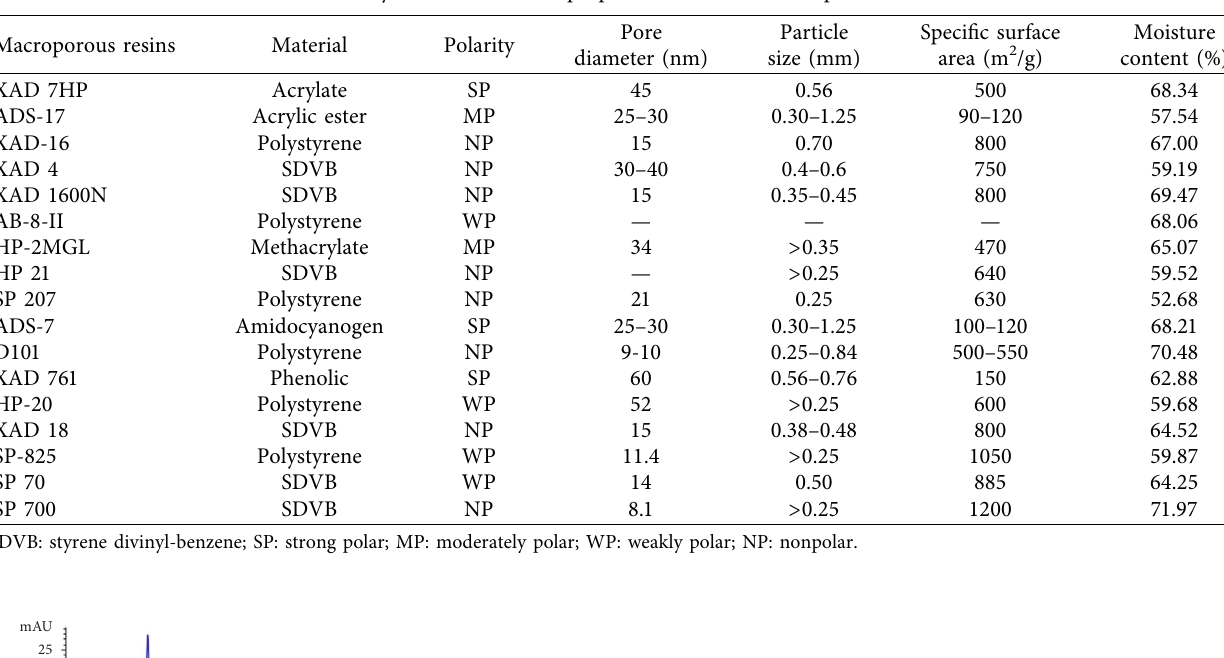
Table 1: Physical and chemical properties of the test macroporous resins.